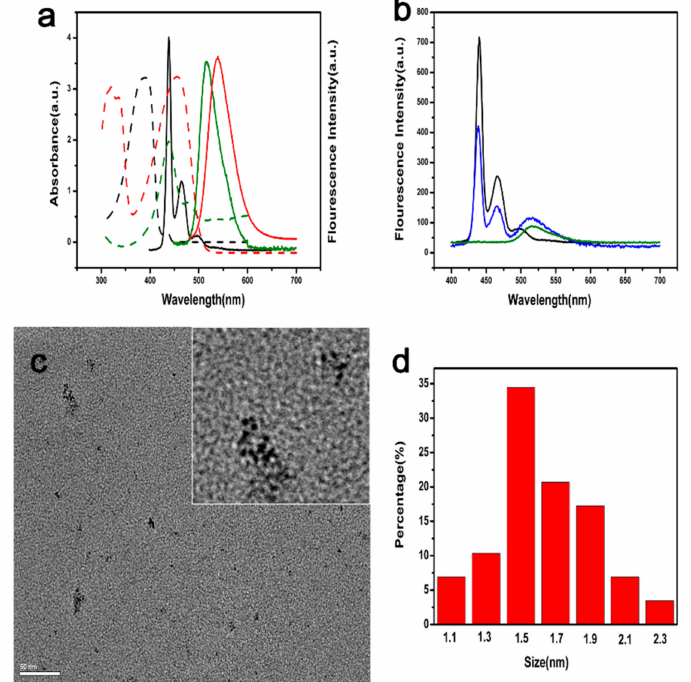
Figure 1. ( a ) Absorption of PFO (black dotted line), PFBT (red dotted line), and FITC (green dotted line), and emission spectra of PFO (black solid line), PFBT (red solid line), and FITC (green solid line) when excited at the optimal wavelength. ( b ) Emission spectra of PFO (black solid line), Pdots-PF (blue solid line), and FITC (green solid line) when excited at 380 nm. ( c ) TEM of Pdots-PF. Scale bar represents 50 nm. The inset shows the enlarged view of TEM of Pdots-PF. ( d ) The particle size distribution of